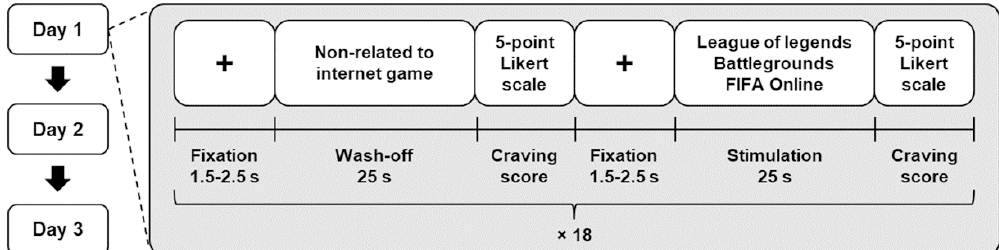
Figure 1. Schematic diagram of the experimental paradigms. We alternately presented video clips that were irrelevant (mostly natural scenery) and relevant (FIFA Online, League of Legends, and Battlegrounds) to online games. A total of 36 videos were presented to each participant, all of which were different from each other and counterbalanced.